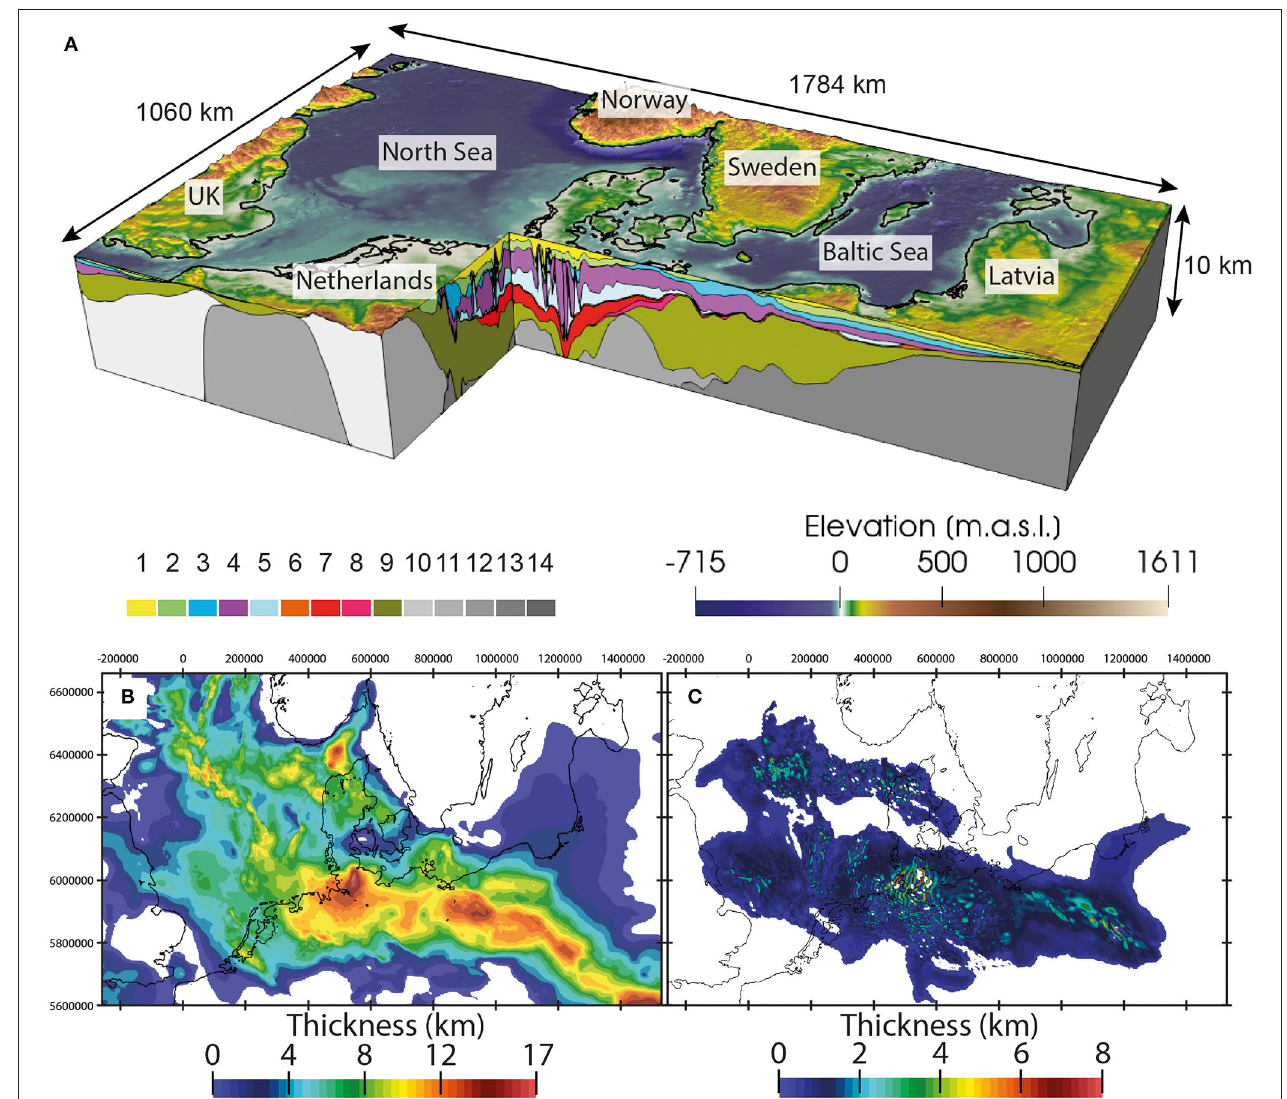
FIGURE 1 | Structural model of the Central European Basin System (Maystrenko and Scheck-Wenderoth, 2013; Maystrenko et al., 2020). (A) Clip of the uppermost 10km, 25 × vertical exaggeration. Colors on top: elevation of uppermost slice of the model, vertical interfaces showing the geological layers of the model: 1 = Tertiary, 2 = Cretaceous, 3 = Jurassic, 4 = Triassic, 5 = Permian Zechstein Salt, 6 = Permian Carbonates, 7 = Rotliegend Sediments, 8 = Permocarboniferous Volcanics, 9 = Pre-Permian Sediments, 10 = Bohemian Granite, 11 = Variscan Crust, 12 = Laurentia Crust, 13 = Avalonia Crust, 14 = Baltica Crust. (B) Cumulative thickness distribution of the sedimentary layers (1–9); (C) Thickness distribution of the Permian Zechstein Salt. Coordinates are in UTM Zone 32N.